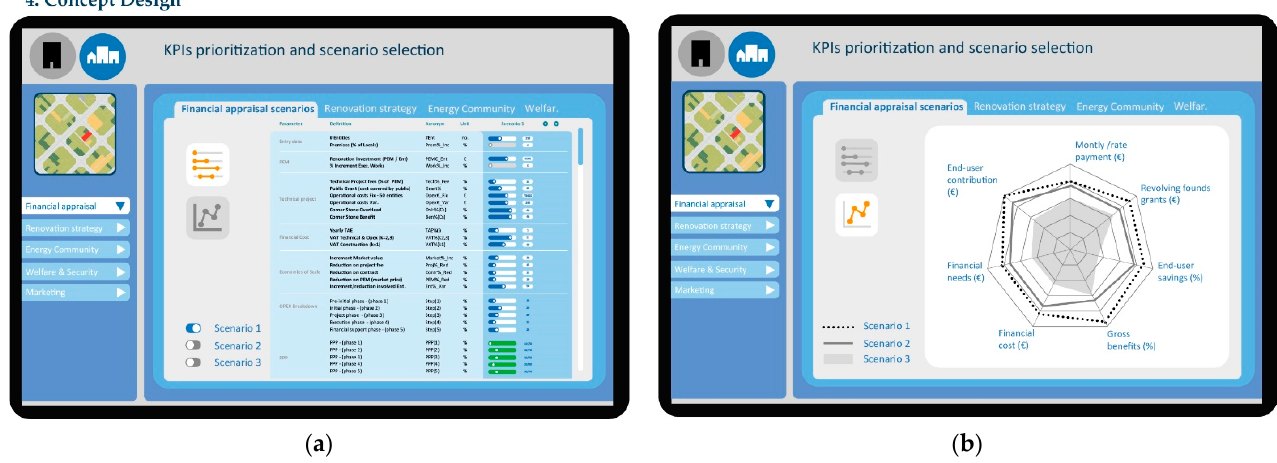
Figure 5. Extract of the PEDRERA model approach, expected visualization in the urbanZEB tool: ( a ) concept design based on financial appraisal and KPIs prioritization; ( b ) scenario visualization for scenario selection according to priorities from stakeholders. Source: authors.